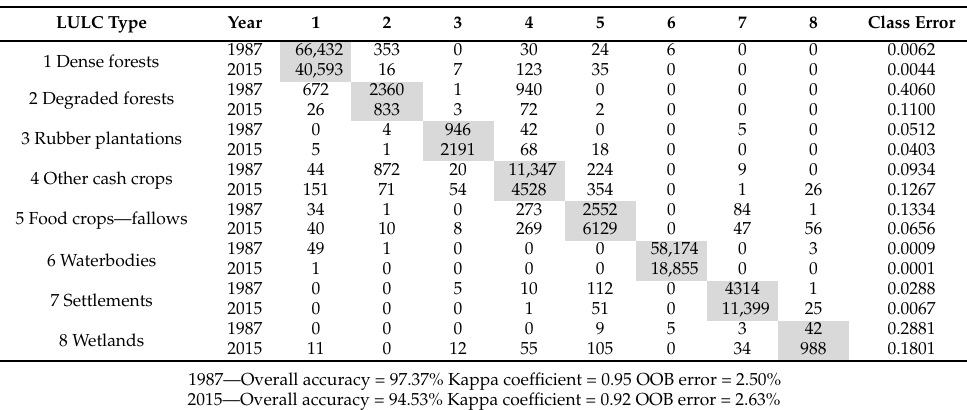
Table 2. Confusion matrix based on pixels of the LULC of 1987 and 2015 of south-western C ô te